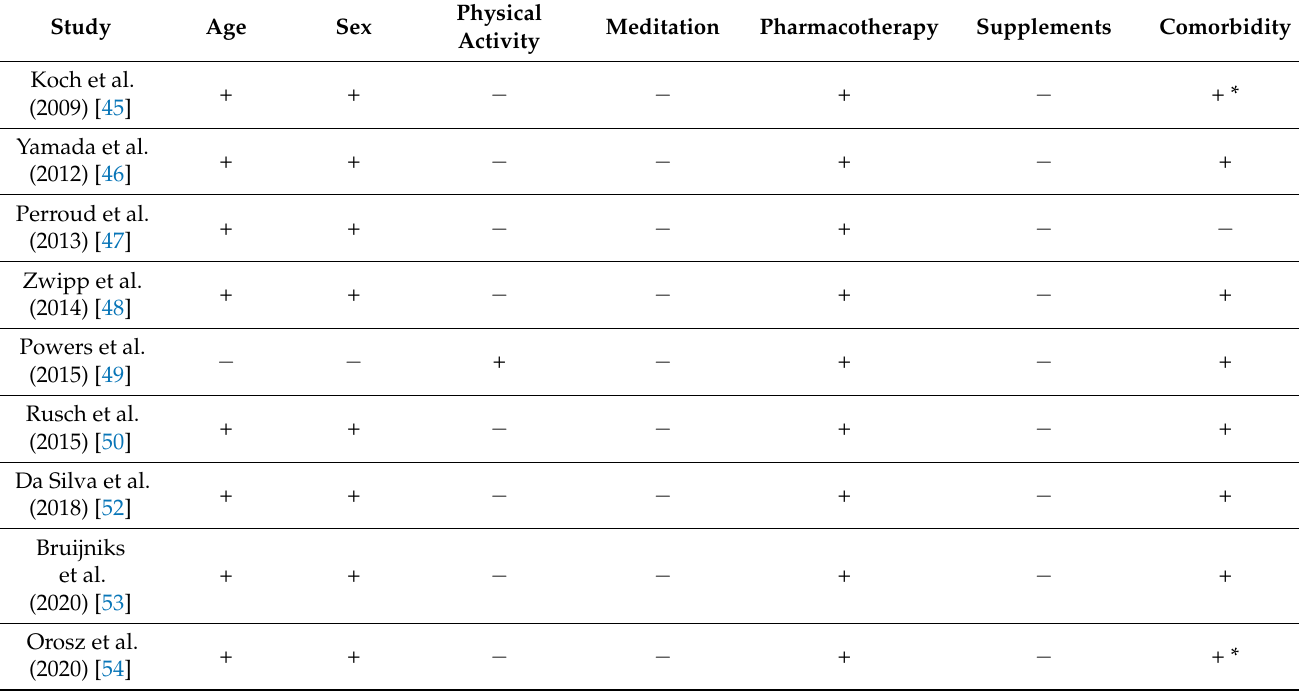
Table 2. Factors influencing peripheral BDNF concentration levels controlled in the studies included in the review. Physical Meditation Study Age Sex Activity